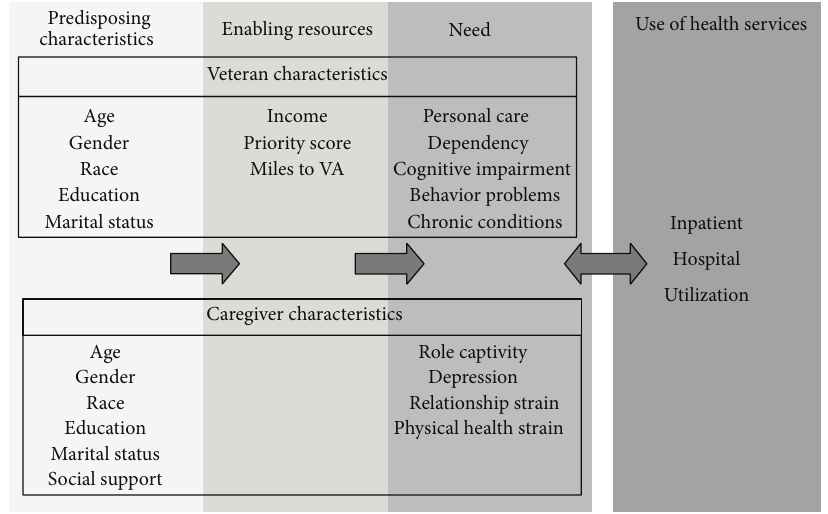
Figure 1: Behavioral model of inpatient hospitalization for veterans with